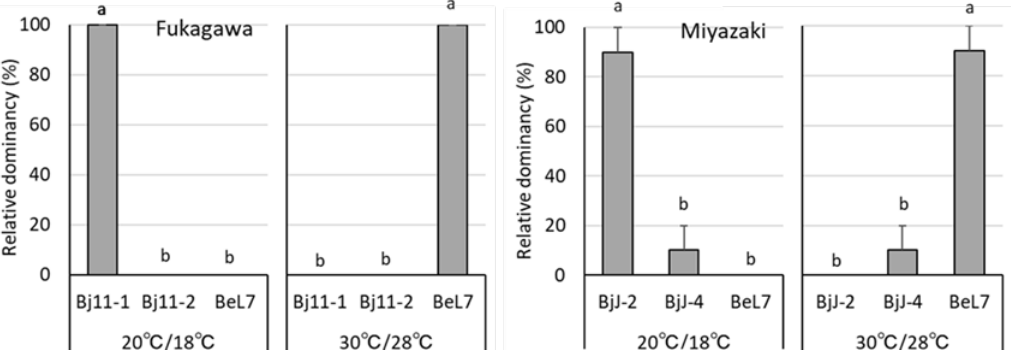
Figure 4. Effects of temperature on relative abundancy of inoculated Bradyrhizobium spp. strains in soybean. Soybean was cultivated in a phytotron at 20/18 °C (day/night) and 30/28 °C at 16/8 h cycle. Fukagawa strains: B. japonicum Hh 16-9 (Bj11-1), B. japonicum Hh 16-25 (Bj11-2), and B . elkanii Hk 16-7 (BeL7); Miyazaki strains: B. japonicum Kh 16-43 (Bj10J-2), B. japonicum Kh 16-64 (Bj10J-4), and B. elkanii Kh 16-7 (BeL7). The bars represent the standard deviation ( n = 3) and different letters indicate significant differences at p < 0.05 by Duncan’s test.